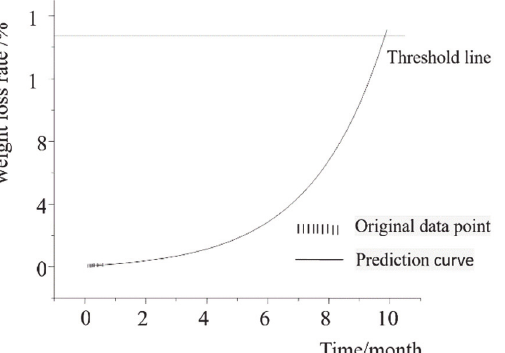
Figure 3. The Prediction curve and original data point at perma- nently soaked in water environment.